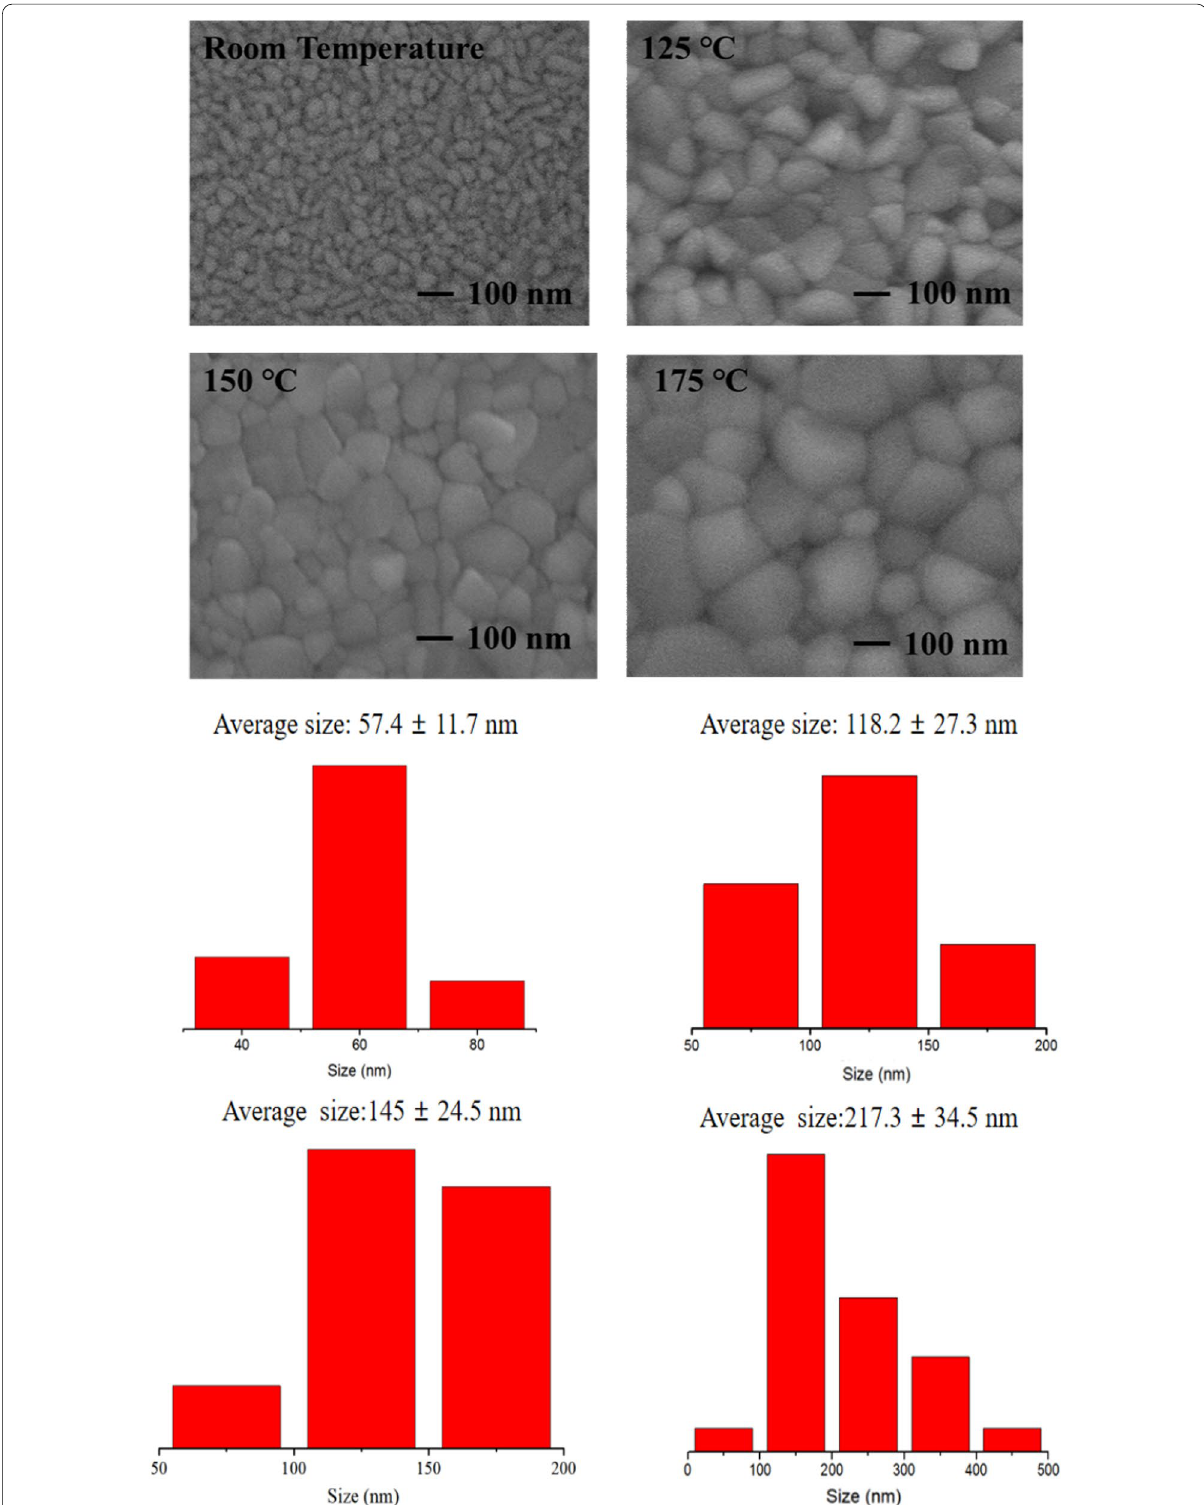
Fig. 4 SEM spectra and particle size distribution of CsPbBr 3 films at different substrate